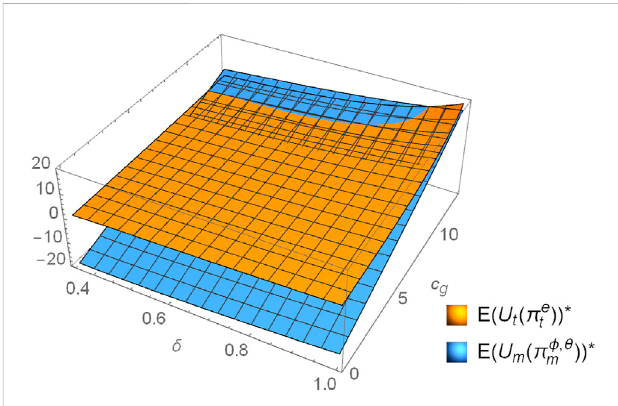
FIGURE 6 The impact of δ and c g on the expected utility of the manufacturer and the ESCO.